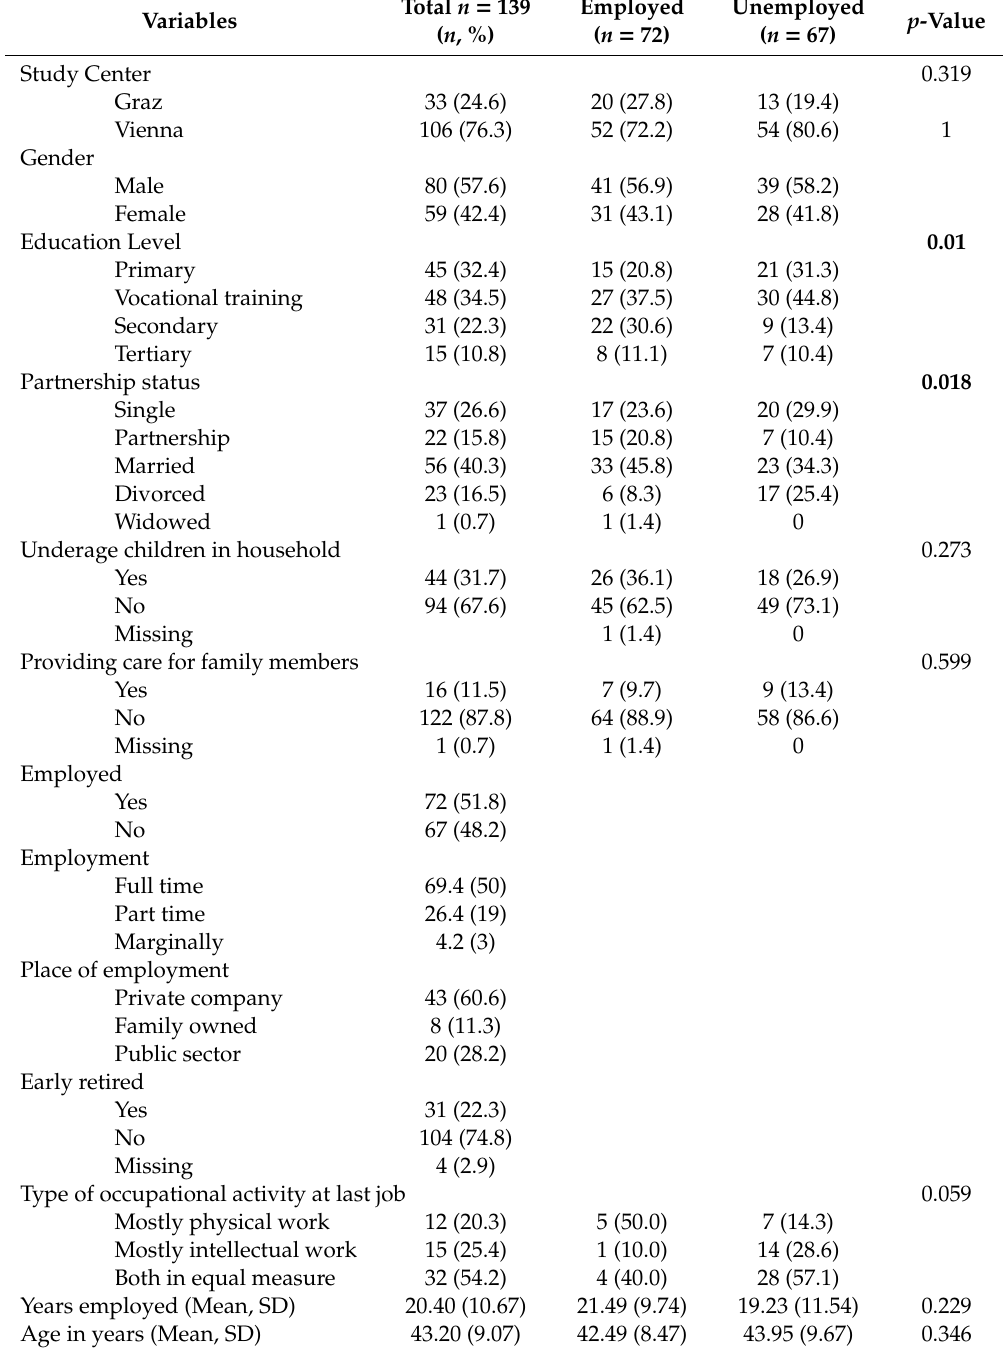
Table 1. Sociodemographic data. Analysis of sociodemographic data in all participants and stratified by current employment